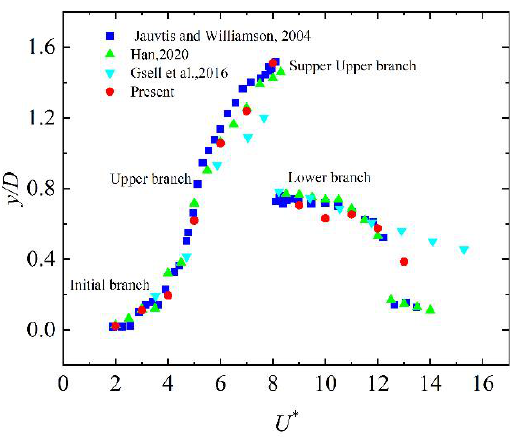
Figure 7. Variation of transverse amplitude with reduced velocity [22,24,25].